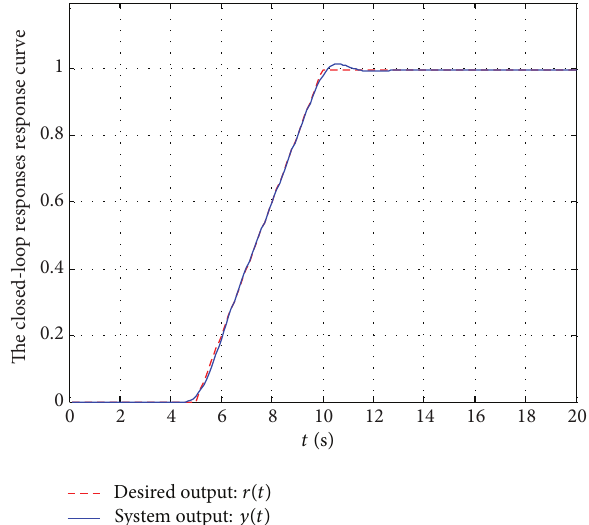
Figure 2: Closed-loop responses of system (33) with 𝑙 𝑟 = 2